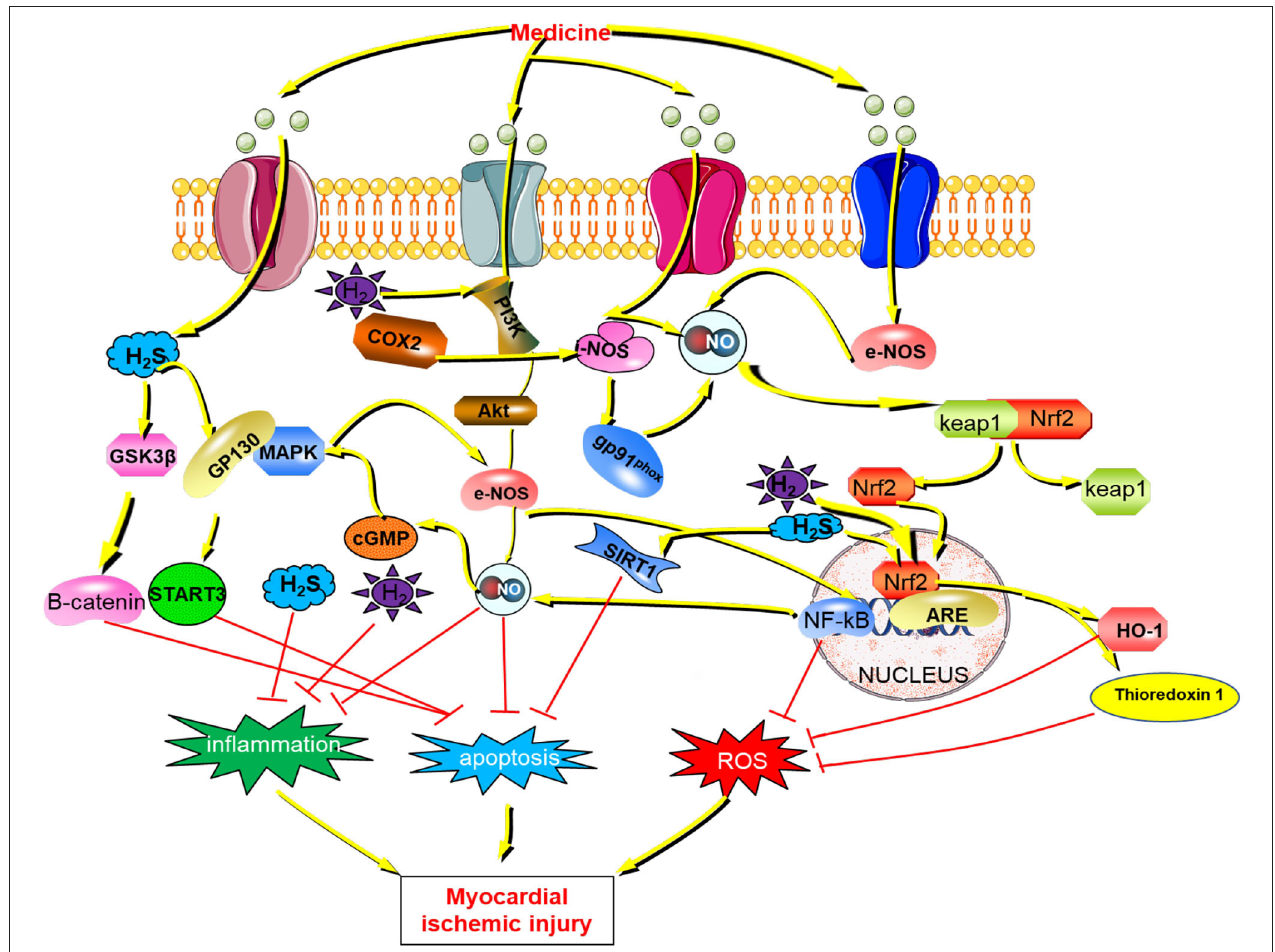
FIGURE 4 | The mechanism of gaseous signaling molecules (NO, H 2 , H 2 S) against myocardial ischemic injury H 2 S, hydrogen sulfide; GSK3 β , Glycogen synthase kinase-3 β ; GP130, Glycoprotein 130;STAT3, Signal transducers and activators of transcription 3; PI3K, class I phosphatidylinositol 3-kinase; COX2, Cyclooxygenase 2; AKT, Serine/threonine protein kinase; MAPK, mitogen-activated protein kinase; cGMP, cyclic guanosinc monophosphate; NO, nitric oxide; i-NOS, Inducible nitric oxide synthase; e-NOS, endothelial nitric oxide synthase; Keap1, Kelch Like ECH Associated Protein 1; Nrf2, Nuclear factor erythroid 2 p45-related factor 2; NF-kB, Nuclear factor-kappa B; HO-1, Hemeoxygenase-1; SIRT1, Sirtuin1; ROS, Reactive oxygen